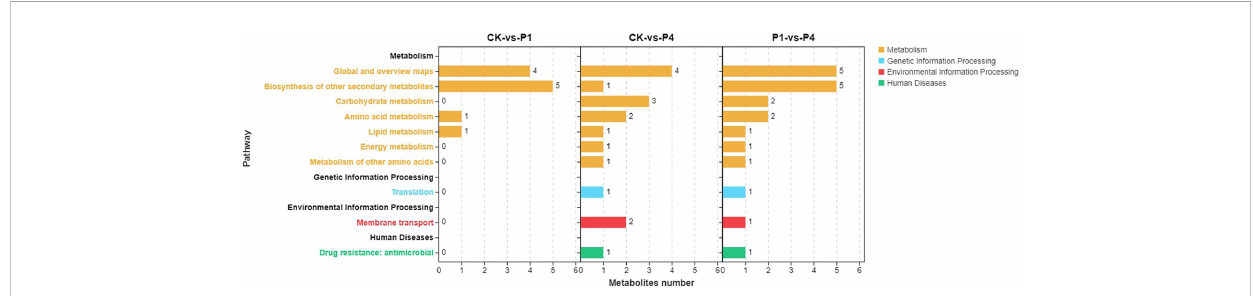
FIGURE 6 KEGG pathway enrichment analysis of the changed metabolites under different P treatments. KEGG, Kyoto Encyclopedia of Genes and